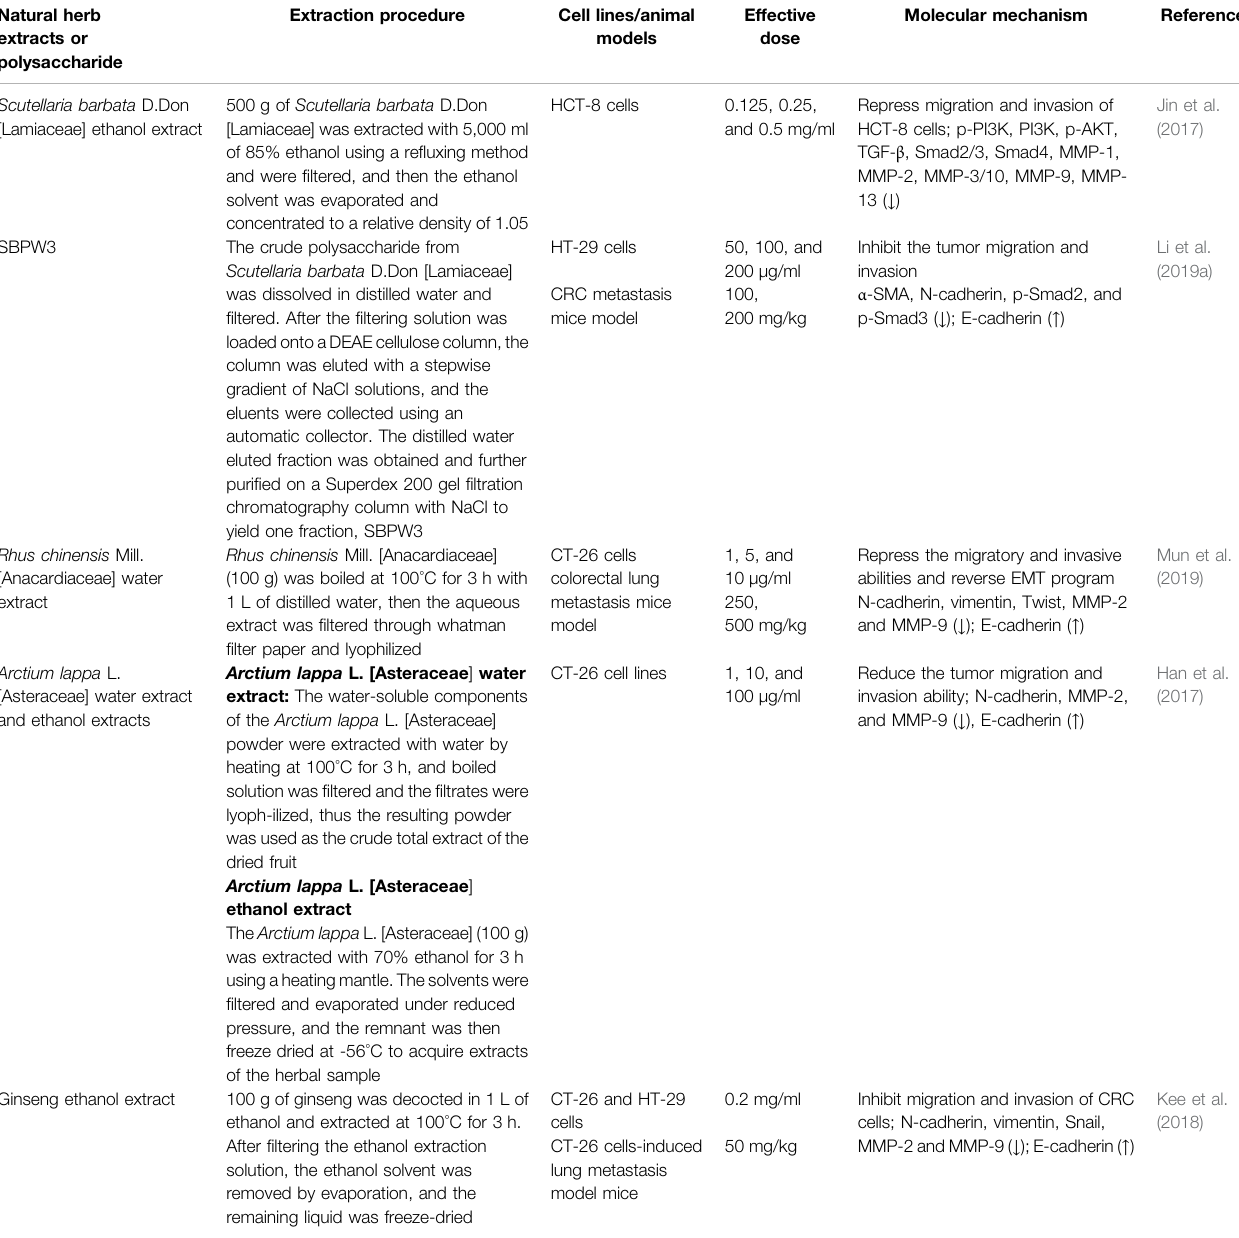
TABLE 2 | Targeting of EMT-related signaling pathways involved in metastatic CRC by medicinal herb extracts in vitro and in vivo . Natural herb extracts